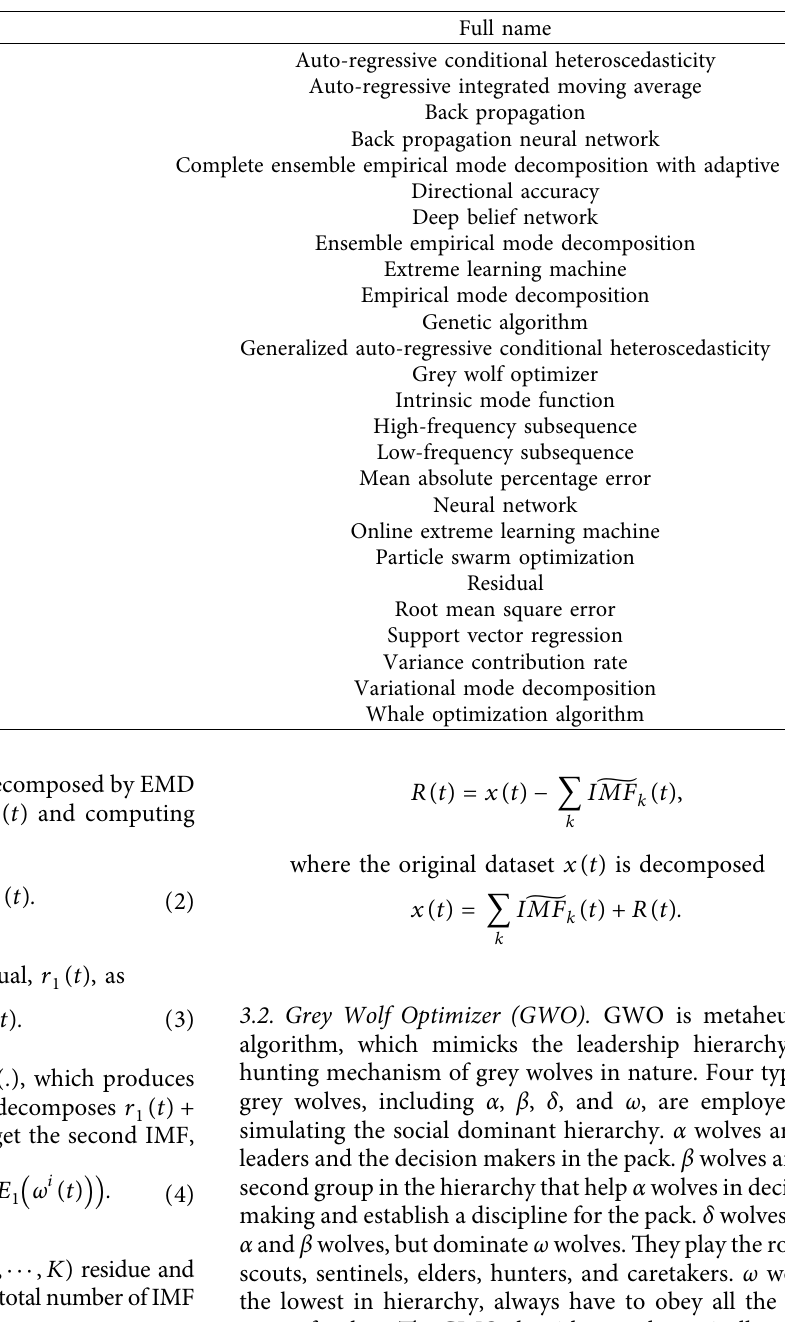
Table 1: List of